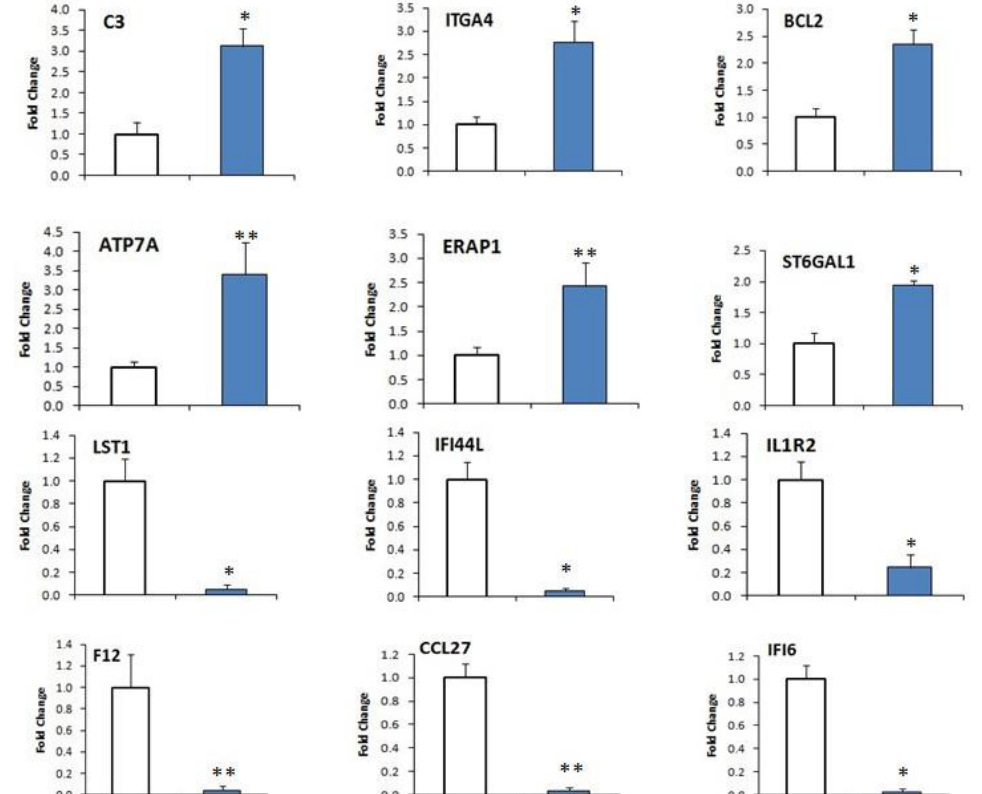
Figure 5. Validation of DEGs by Quantitative Reverse-Transcriptase Polymerase Chain Reaction (qRT-PCR) with RNA sequence results between resistant and susceptible goats. Clear bars represent the resistant goats and the blue bars represent susceptible goats. All samples were normalized by β-actin housekeeping gene. Among the selected 12 genes, 6 genes ( C3 , ITGA4 , BCL2 , ATP7A , ERAP1 , and ST6GAP1 ) were highly expressed in susceptible goats and another 6 genes ( LST1 , IFI44L , IL1R2 , F12 , CCL27 , and IFI6 ) were lower expressed in susceptible goats compared with resistant goats. * Significant at p < 0.01 and ** significant at p < 0.05, based on assuming unequal variances Student’s t -test. Error bars represent standard error of the mean (SEM).